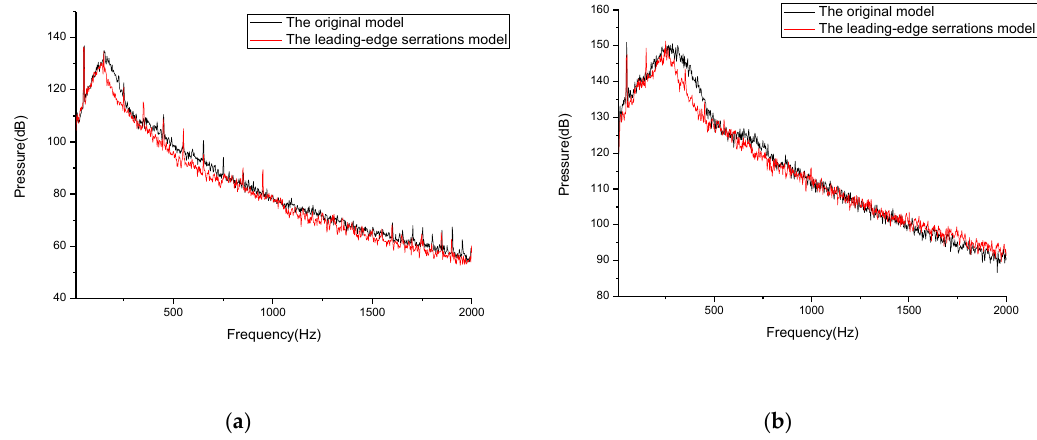
Figure 23. The turbulent fluctuation pressure measured by the fluctuation pressure sensor at different flow velocities. ( a ) 4.62 m/s; ( b ) 8.68 m/s.